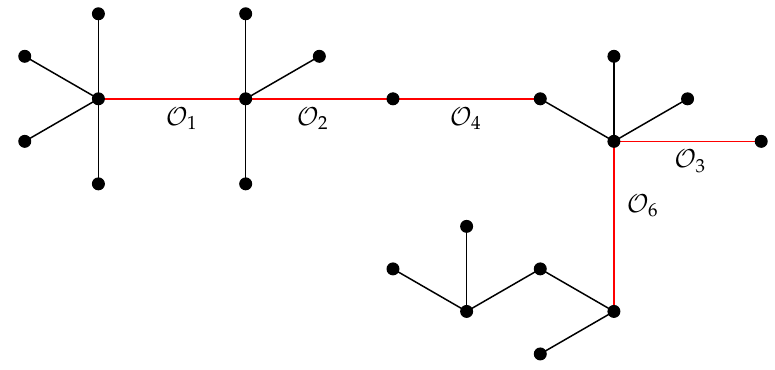
Figure 5. An example of a tree T in the family T , obtained from tree K 1,4 by Operations O 1 , O 2 , O 4 , O 3 and O 6